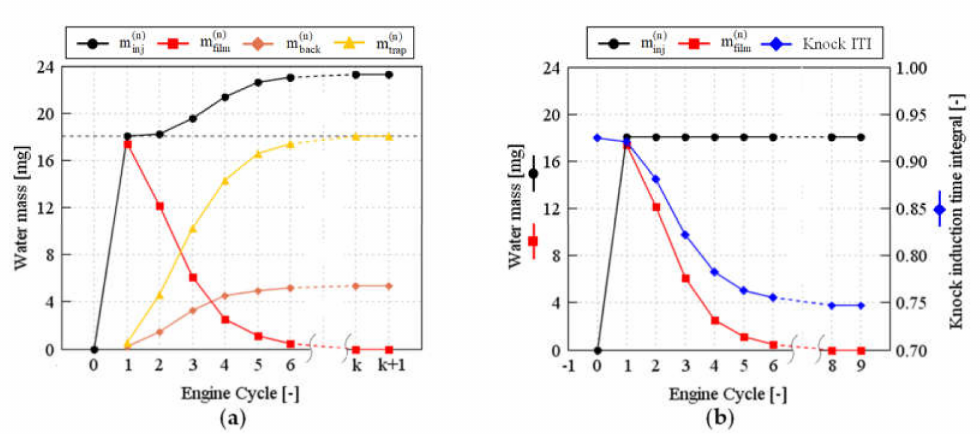
Figure 9. ( a ) The amount of water available before Intake Valve Opening (IVO), water trapped in the wall film, water backflow and water which is present into the cylinder during the combustion process as a function of the consecutive engine cycles with Port Water Injection (PWI); ( b ) The amount of injected water, trapped water in the wall film and the knock induction time integral as a function of the consecutive engine cycles with PWI; k ≥ 13